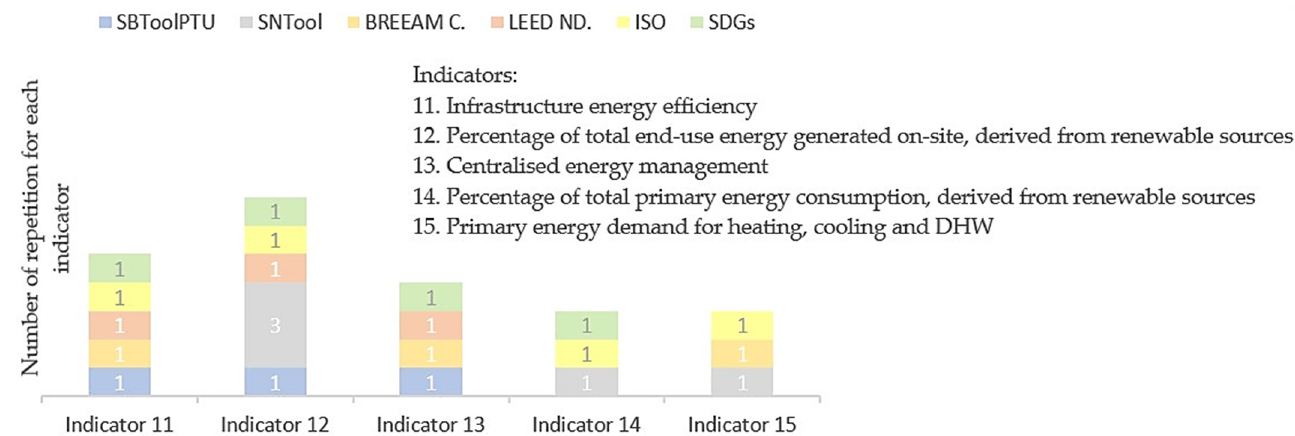
Figure 3. Frequency distribution of each indicator, relevant to the category of essential service availability in SBTool PT _Urban (2018), SNTool Min (2020), BREEAM-C (2012), LEED-ND (2018), ISO 37120, and SDGs.